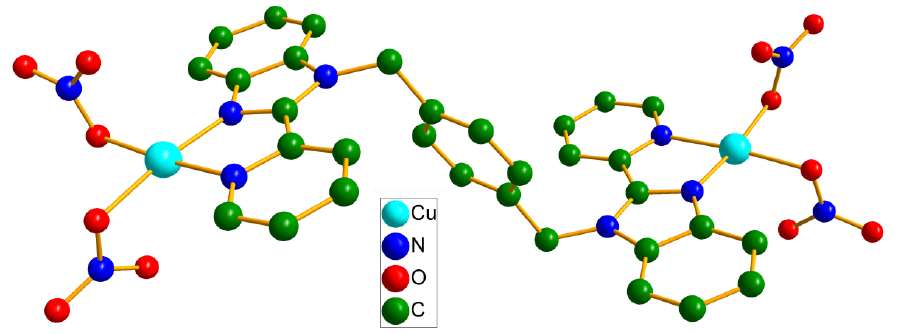
Figure 1. The coordination environment of Cu Ⅱ ion and bicopper core in CuBMMB.